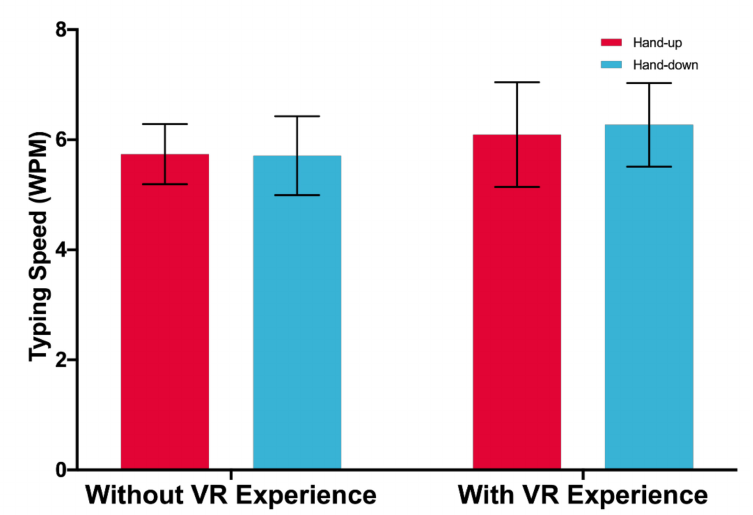
Figure 5. Words per minute. Error bars represent 95%